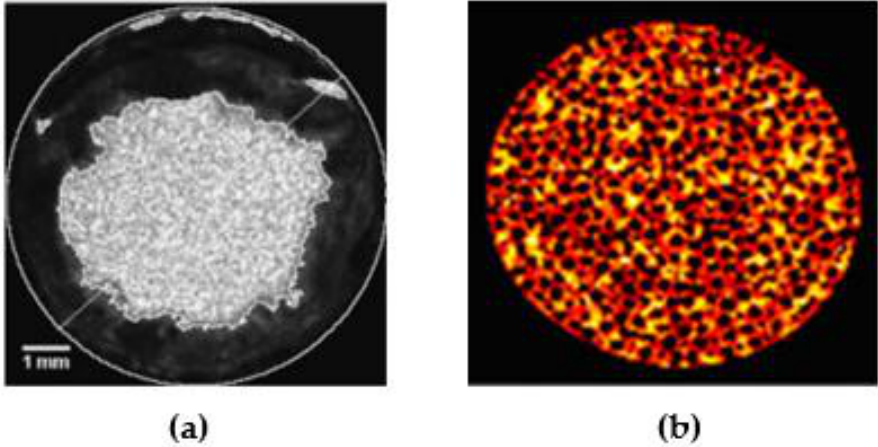
Figure 4. 2D NMR imaging for biofilm in ( a ) a tube bioreactor with a diameter of 7.7 mm (reproduced with permission from [43], Copyright John Wiley and Sons, 2003) and ( b ) monodisperse beads in a cylinder with a diameter of 5 mm, (reproduced with permission from [59], Copyright Advances in Water Resources , 2007). NMR imaging can be used to confirm biofouling at any area of a porous media but has a lower resolution on the biofilm structure in contrast to X-ray imaging.